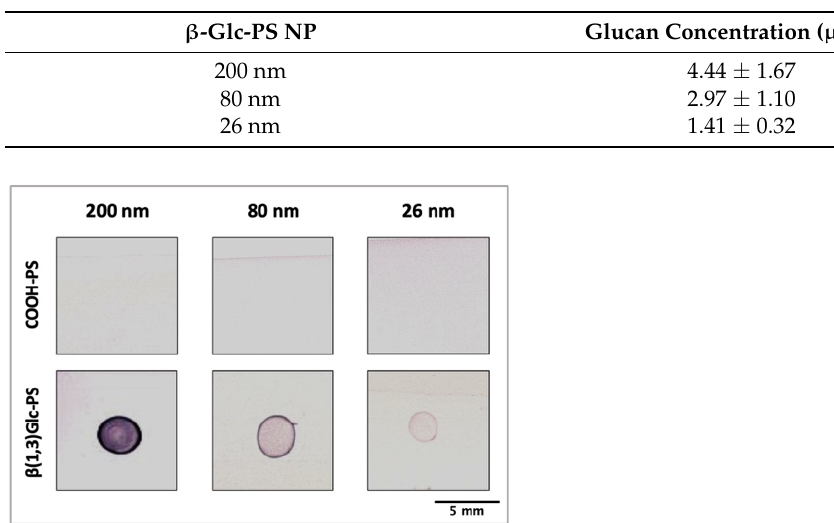
Table 4. β -glucan content on 0.5 mg/mL NP surface after conjugation was quantified according to Dubois et al. Values represent means ± SD.